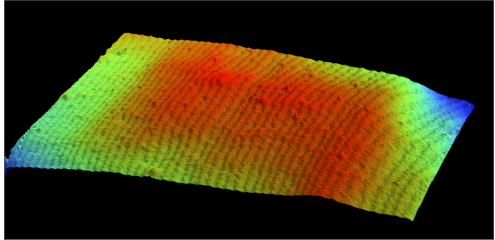
Figure 1. Surface structure of LLDPE